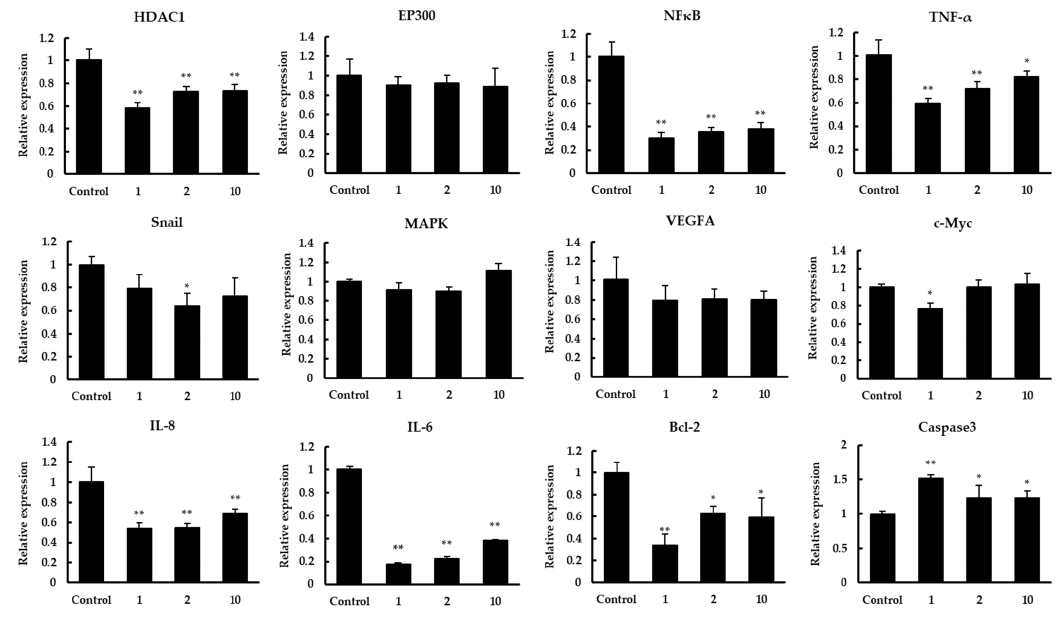
Figure 4. The effect of quinoa peptides 1, 2, 10 on the mRNA transcript levels of HDAC1, EP300, NF κ B, TNF- α , Snail, MAPK, VEGFA, c-Myc, IL-8, IL-6, Bcl-2, and caspase3. The mRNA expression results are displayed as the fold increase of mRNA expression normalized to GAPDH and shown in mean ± SD. * p < 0.05 and ** p < 0.01 versus control group.